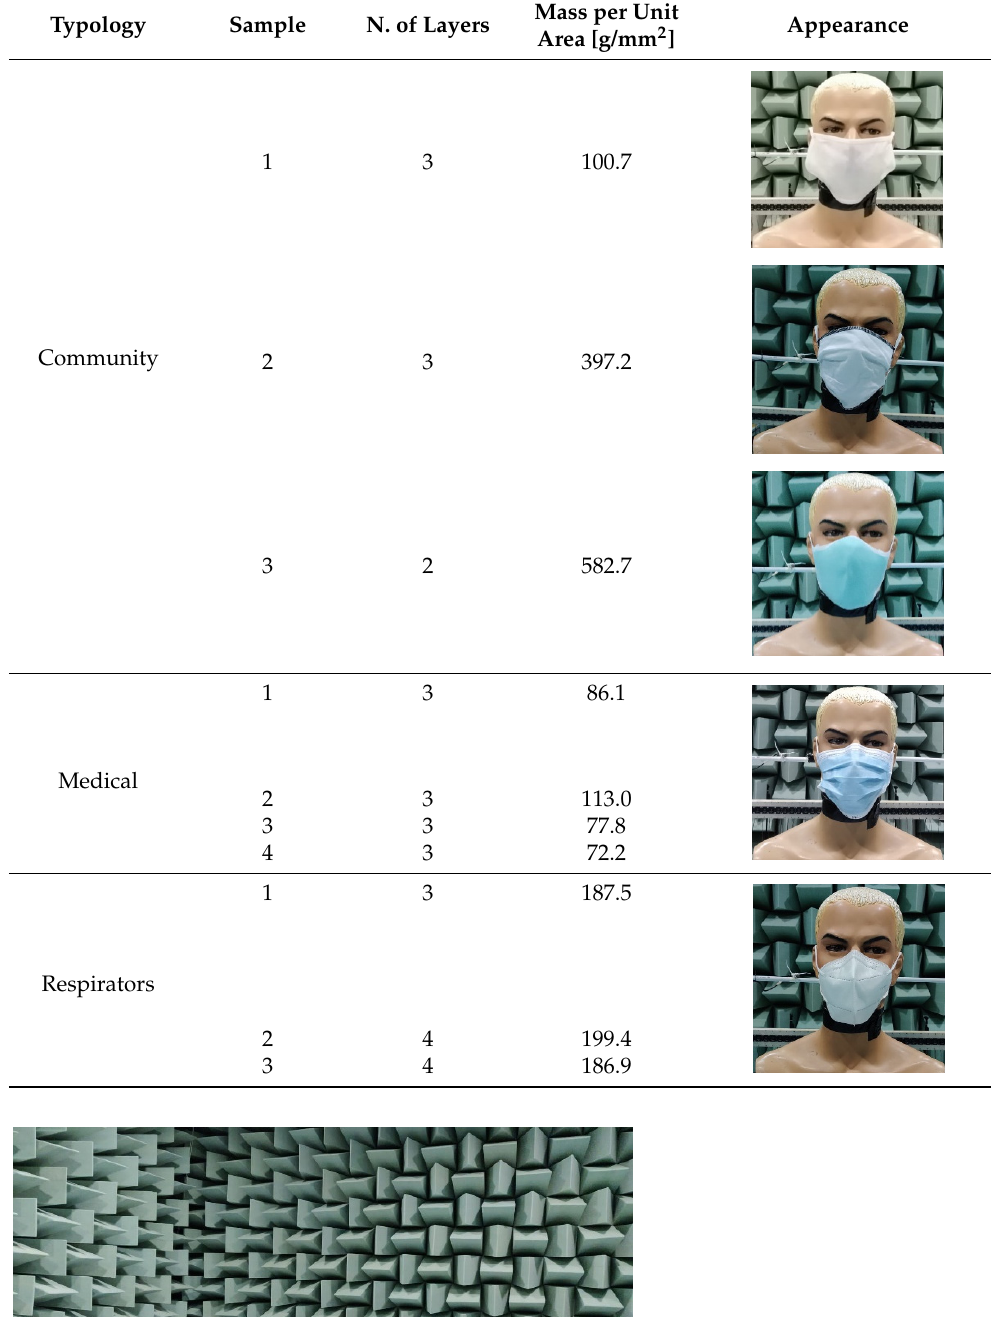
Table 1. Typology and characteristics of the masks tested.